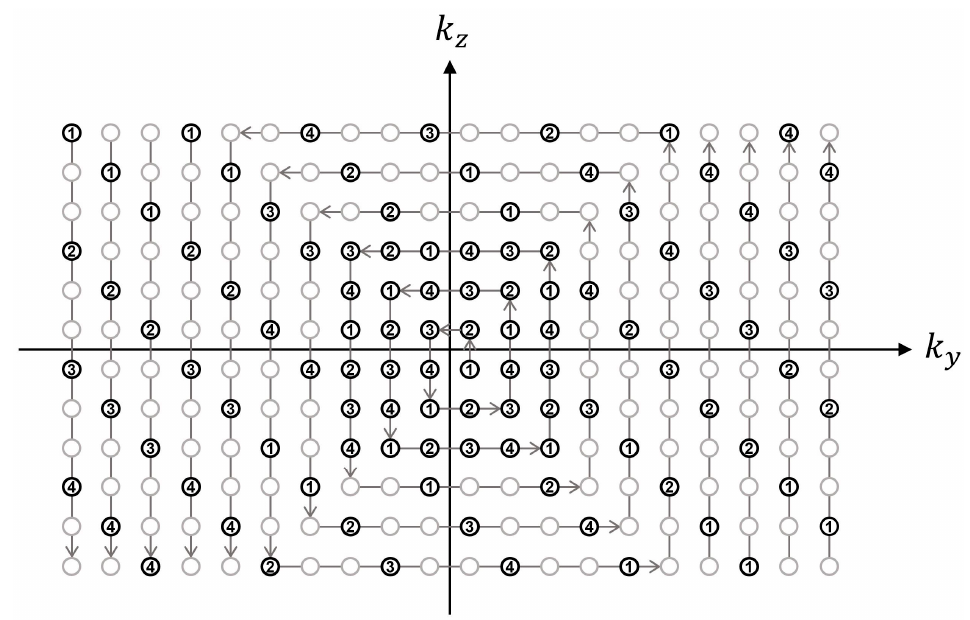
Figure 2. Illustration of square-spiral sampling trajectory in k y -k z space, assuming an acceleration factor = 3, self-calibration size = 6 × 6, and views per segment = 26. The sampling position was first determined by traversing the k y -k z plane in a square-spiral fashion (denoted by gray arrows) while fully sampling the inner region and three-fold under-sampling the outer region. The gray and black circles represent skipped and acquired points, respectively. The resultant sequence of (k y , k z ) locations was then sequentially segmented for each segmented acquisition (denoted by numbers) where the segmentation factor was determined as the total number of samples divided by the number of views to be acquired for each acquisition.